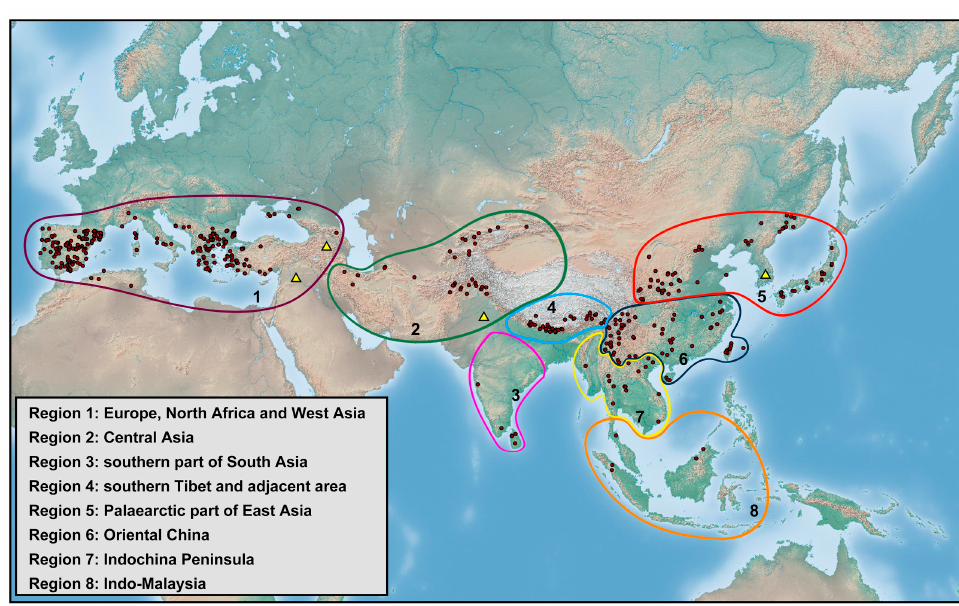
Figure 19. Distribution map of the species of Dilar worldwide. Triangles indicate specimens with imprecise locality.